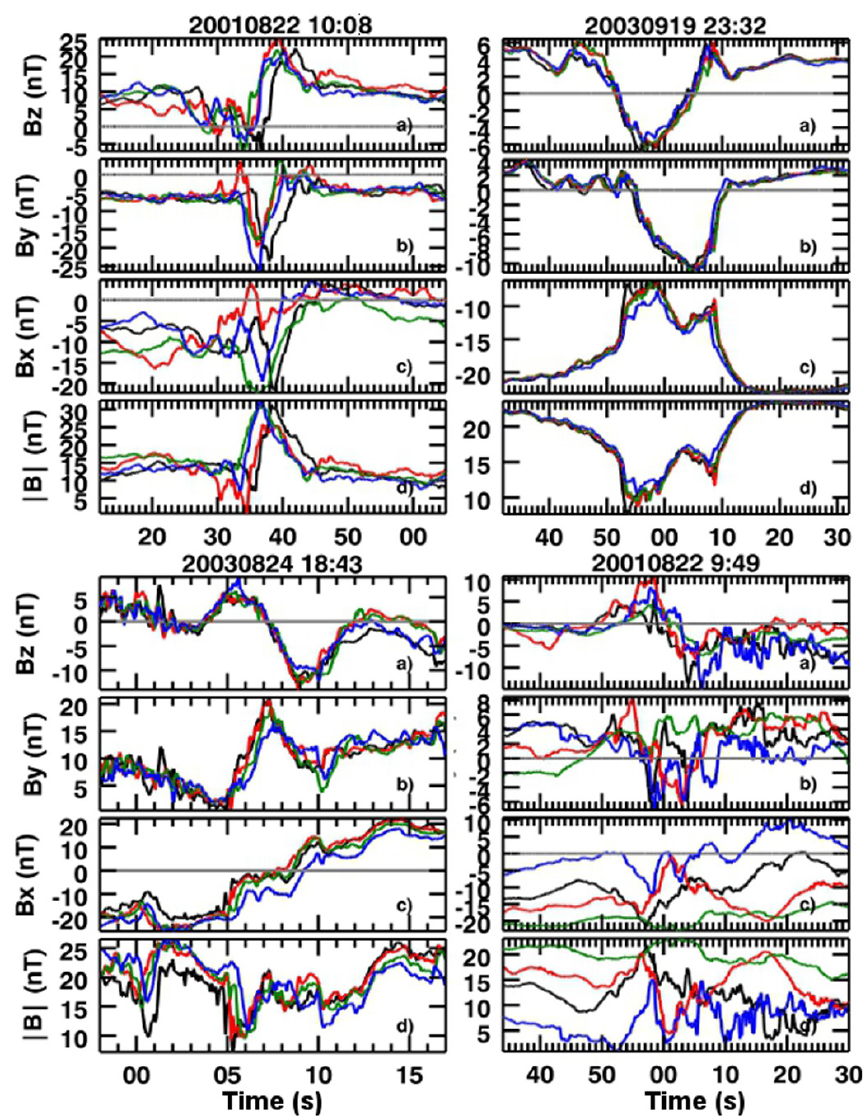
Fig. 2. Flux rope signatures observed on 22 August 2001, 19 September 2003, 24 August 2003 and 22 August 2001 by the four Cluster spacecraft (SC1 black, SC2 red, SC3 green and SC4 blue). The X-axes show seconds after 10:08, 23:32, 18:42 and 09:49GMT, respectively. (a) The B z component showing the bipolar signature, (b) the B y component containing the core field, (c) the B x component and (d) the magnetic field magnitude reaching a local maximum or